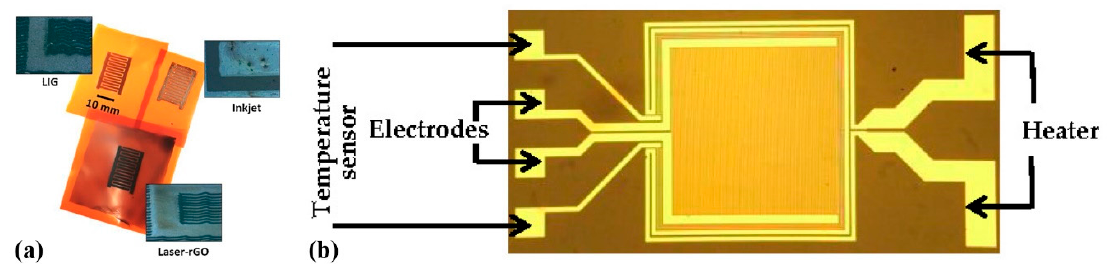
Figure 11. ( a ) The same geometry can be developed on Kapton by either inkjet printing, and laser-patterned rGO or gra- phene (reproduced with permission from [36] copyright 2019, Elsevier); ( b ) a set of electrodes developed via photolithog-